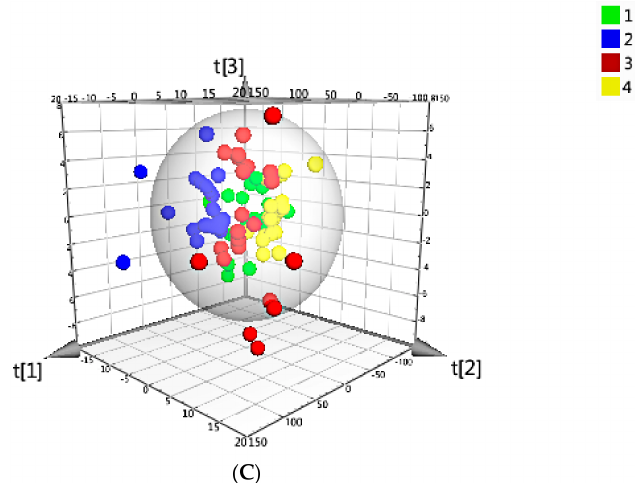
Figure 4. ( A ) Principal component score plot of PC1 and PC2 based on near infrared (NIR) spectra of G. elata samples from eight different cities: 1. Yichang (Hubei) 2. Dabieshan (Anhui) 3. Zhaotong (Yunnan) 4. Hanzhong (Shanxi) 5. Fusong (Jilin) 6. Dandong (Liaoning) 7. Dafang (Guizhou) 8. Funiushan (Henan); ( B ) Principal component score plot of PC1 and PC2 based on NIR spectra of G. elata samples from four main-cultivated areas: 1. Yangtse Gorges and Shennongjia area; 2. Northeast provinces area; 3. Dabieshan area; 4. Southwest provinces area; ( C ) Three-dimensional score plot using PC1, PC2, and PC3 for discriminating G. elata from four main-cultivated areas: 1. Yangtse Gorges and shennongjia area; 2. Northeast provinces area; 3. Dabieshan area; 4. Southwest provinces area.